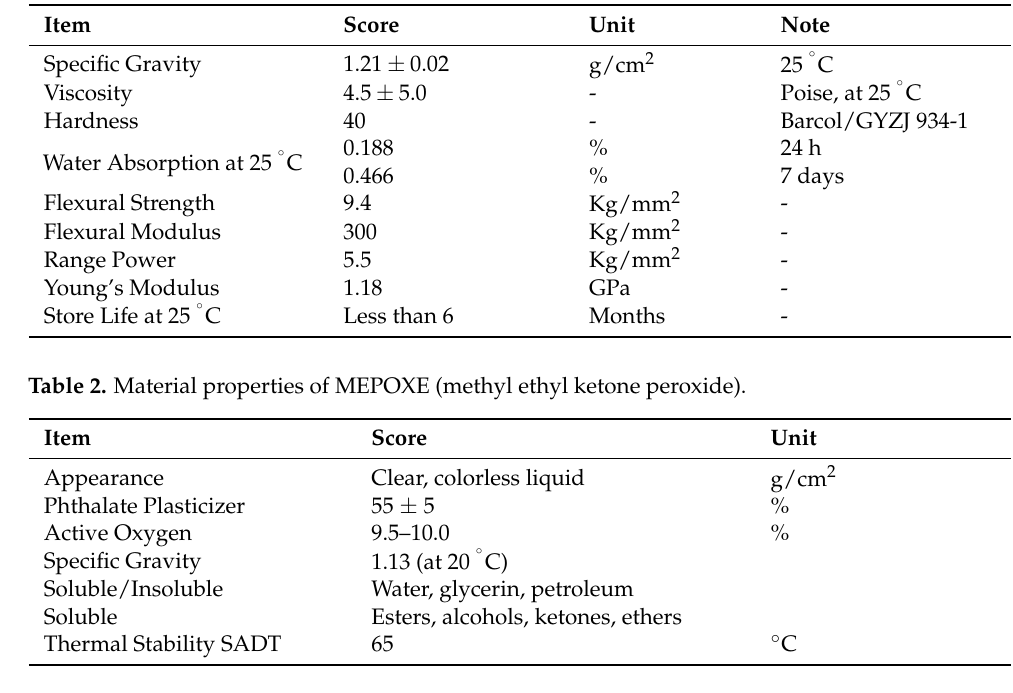
Table 2. Material properties of MEPOXE (methyl ethyl ketone peroxide).